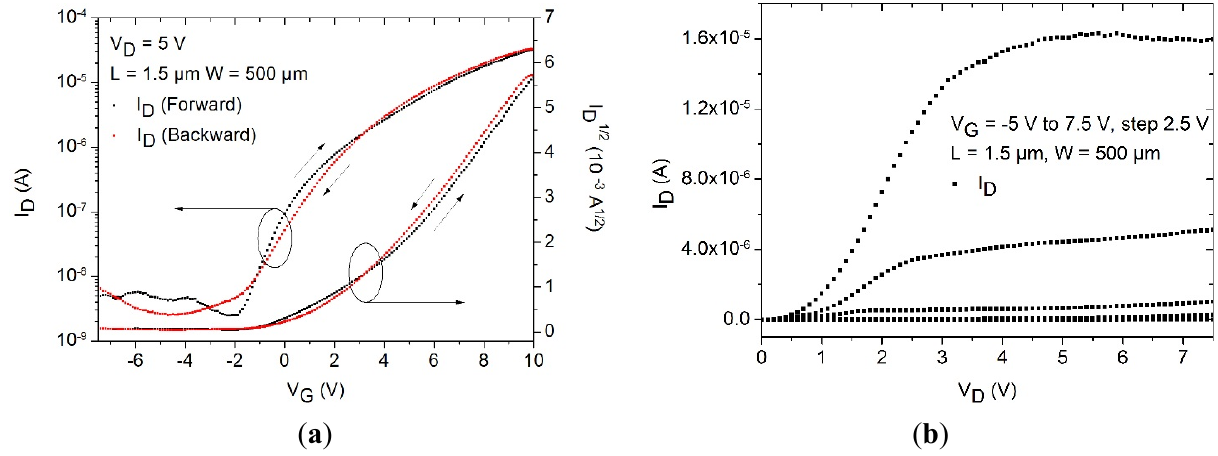
Figure 17. ( a ) Transfer and ( b ) output characteristics of an inverted staggered ZnO nanoparticle TFT using a high- k dielectric (L = 1.5 µm, W = 500 µm and t ins = 200 nm). Reprinted from [72], with permission from Elsevier.